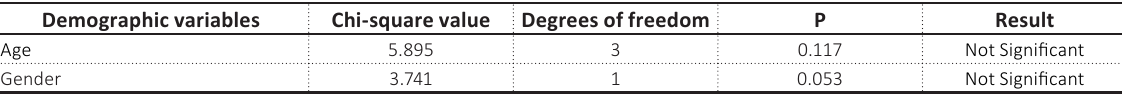
Table 4. Association between demographic variables and emotional discomfort